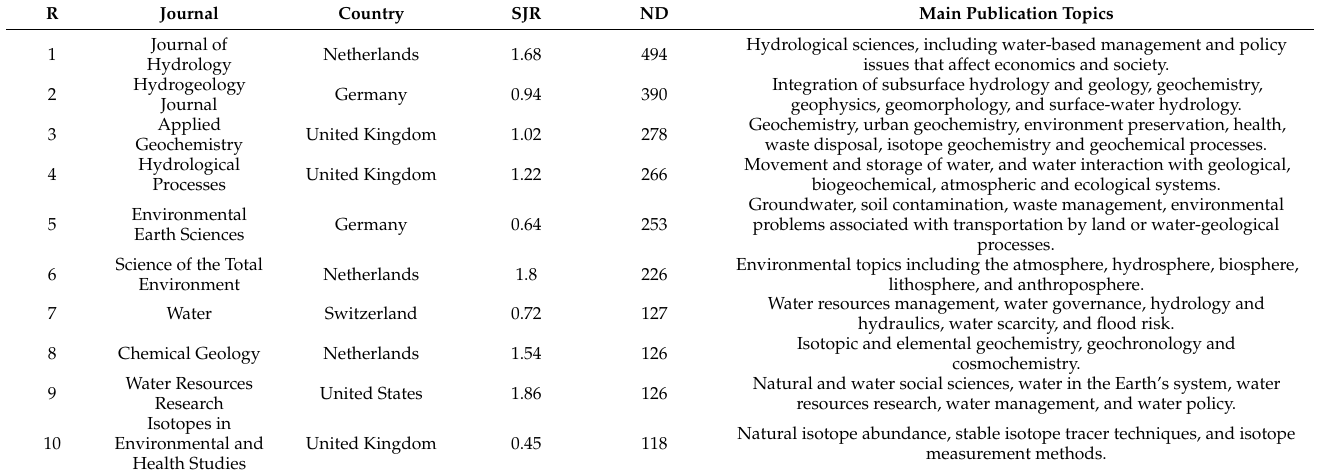
Table 3. Main Information of the top 10 of the most relevant sources in GSI.